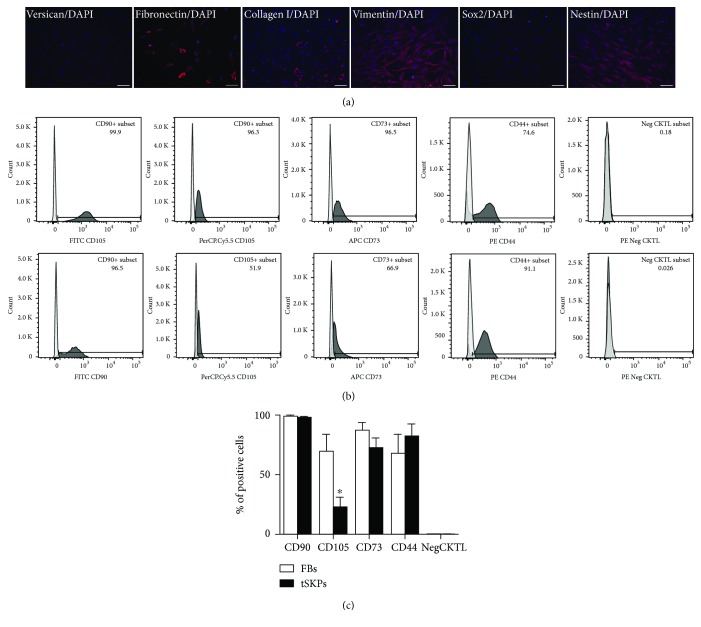
Characterization of primary adherent FBs and tSKPs. (a) Immunocytochemical of FBs. FBs expressed Fibronectin (red), Collagen I (red), Vimentin (red), and Nestin (red) and rarely expressed Versican (red), while were negative for Sox2 (red). Nuclei of all the cells were counterstained with DAPI (blue). (b) Cell surface marker expression of FBs (upper panel) and tSKPs (lower panel). Both FBs and tSKPs expressed CD90, CD105, CD73, and CD44, while lacking expression of negative cocktails. The expression rate of CD105 in FBs was significantly higher than in tSKPs (p < 0.05). (c) Histogram of the CD antigen expression. The percentage of FB expressed CD105 was significantly increased versus tSKPs. ∗p < 0.05. Scale bars: 100 μm.